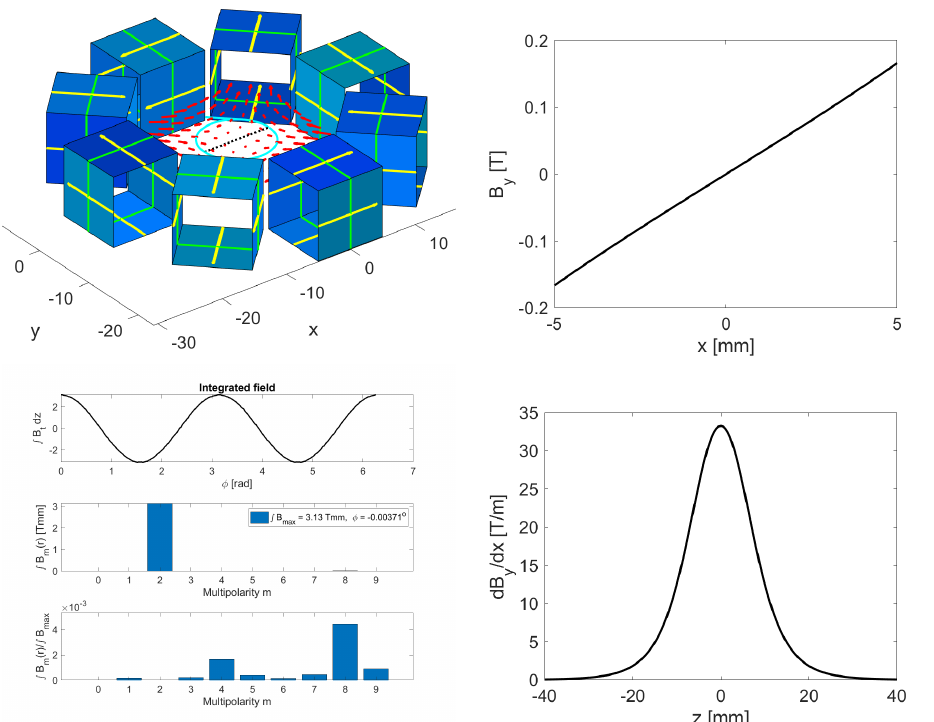
Figure 3. Top left: the eight cubes for a quadrupole are shown as hollow blue cubes and the magnetic field by red arrows. Top right: the vertical field B y along the black dotted line shown on the top-left image. Bottom right: the gradient dB y / dx along the axis perpendicular through the center of the ring. Bottom left: the tangential field on the cyan circle (upper panel), the dominant field harmonic, here for a quadrupole (middle); and the relative strength for the unwanted multipoles